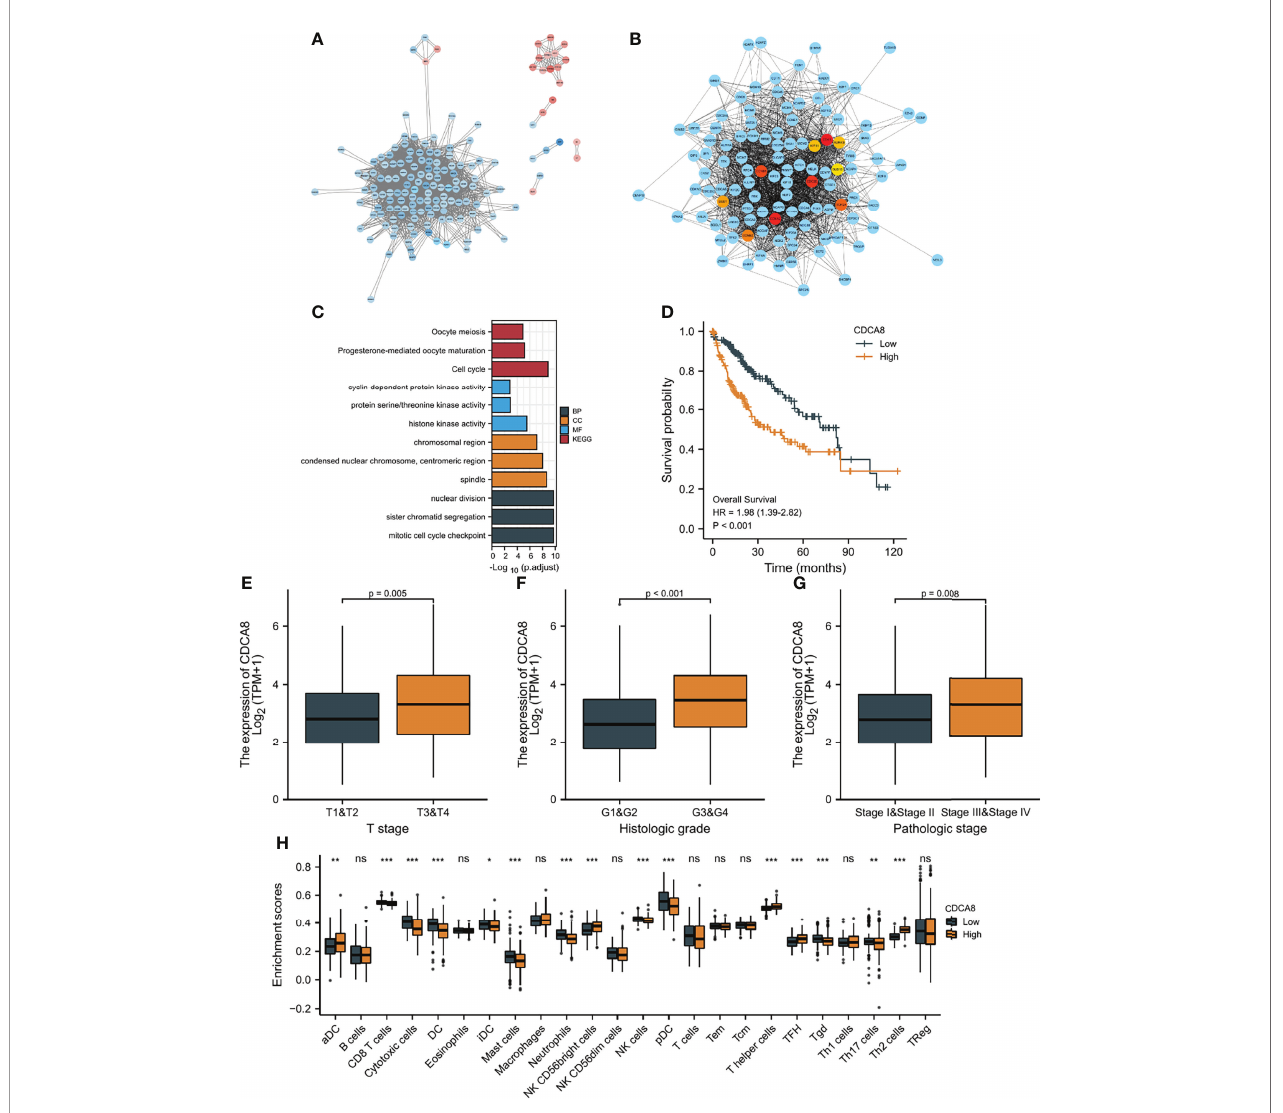
FIGURE 10 | Protein-protein interaction (PPI) analysis. (A) PPI network constructed using Cytoscape; Blue: high expression DEGs in high-risk group, red: high expression DEGs in low-risk group. (B) Top ten hub genes screen by degree method. (C) GO and KEGG analyses of top ten hub genes. (D) K-M curves of CDCA8 expression level. (E – G) The relationship between CDCA8 expression level and clinicopathological characteristics. (H) The difference in immune in fi ltration fraction between low and high expression groups of CDCA8 statistical signi fi cance is indicated by the following symbols: ns, p ≥ 0.05; *, p < 0.05; **, p < 0.01; ***, p <